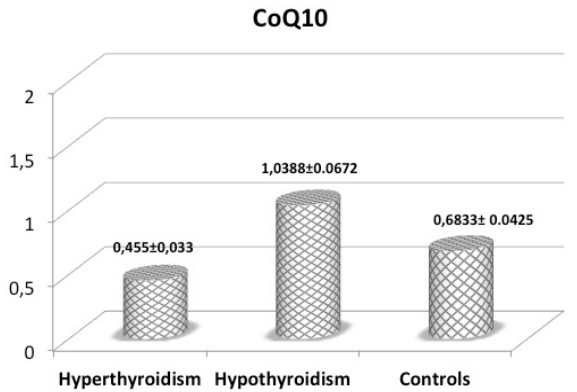
Figure 1. Mean (±SEM) plasma CoQ hypothyroidism and control